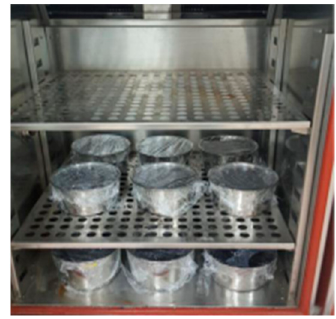
Figure 2. Freeze–thaw condition chamber.